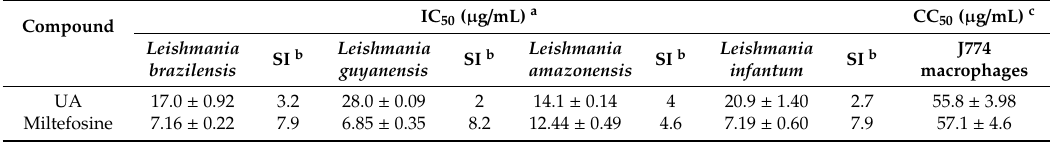
Table1. In vitroleishmanicidalactivityofursolicacid(UA)on Leishmania promastigotesandcytotoxicity on J774 macrophages. Miltefosine was used as the reference drug.